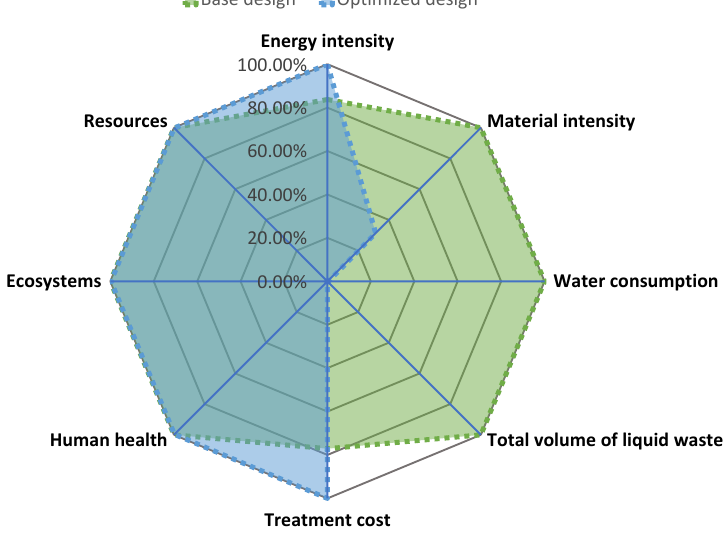
Figure 7. Radial chart showing normalized performance of evaluated indicators.